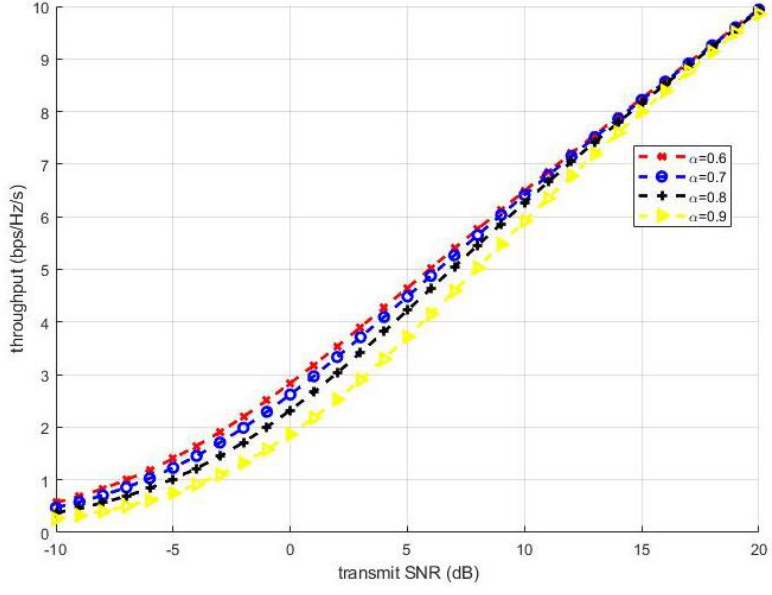
Figure 12. NOMA throughput with different α